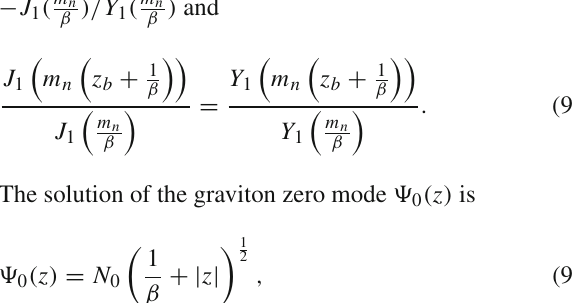
π m 2 (cid:13) 1 becomes n 4 β 2